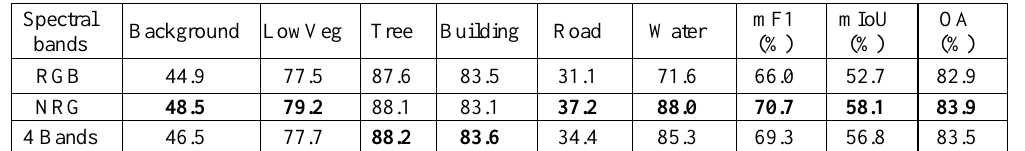
Table 2. Performance of FPN-VGG models with different input bands. The metric for individual class is F1 (%). Initialization approach Random ImageNet Table 3. Performance of FPN-VGG models trained with different initialization approaches. The metric for individual class is F1 (%). Loss function Categorical